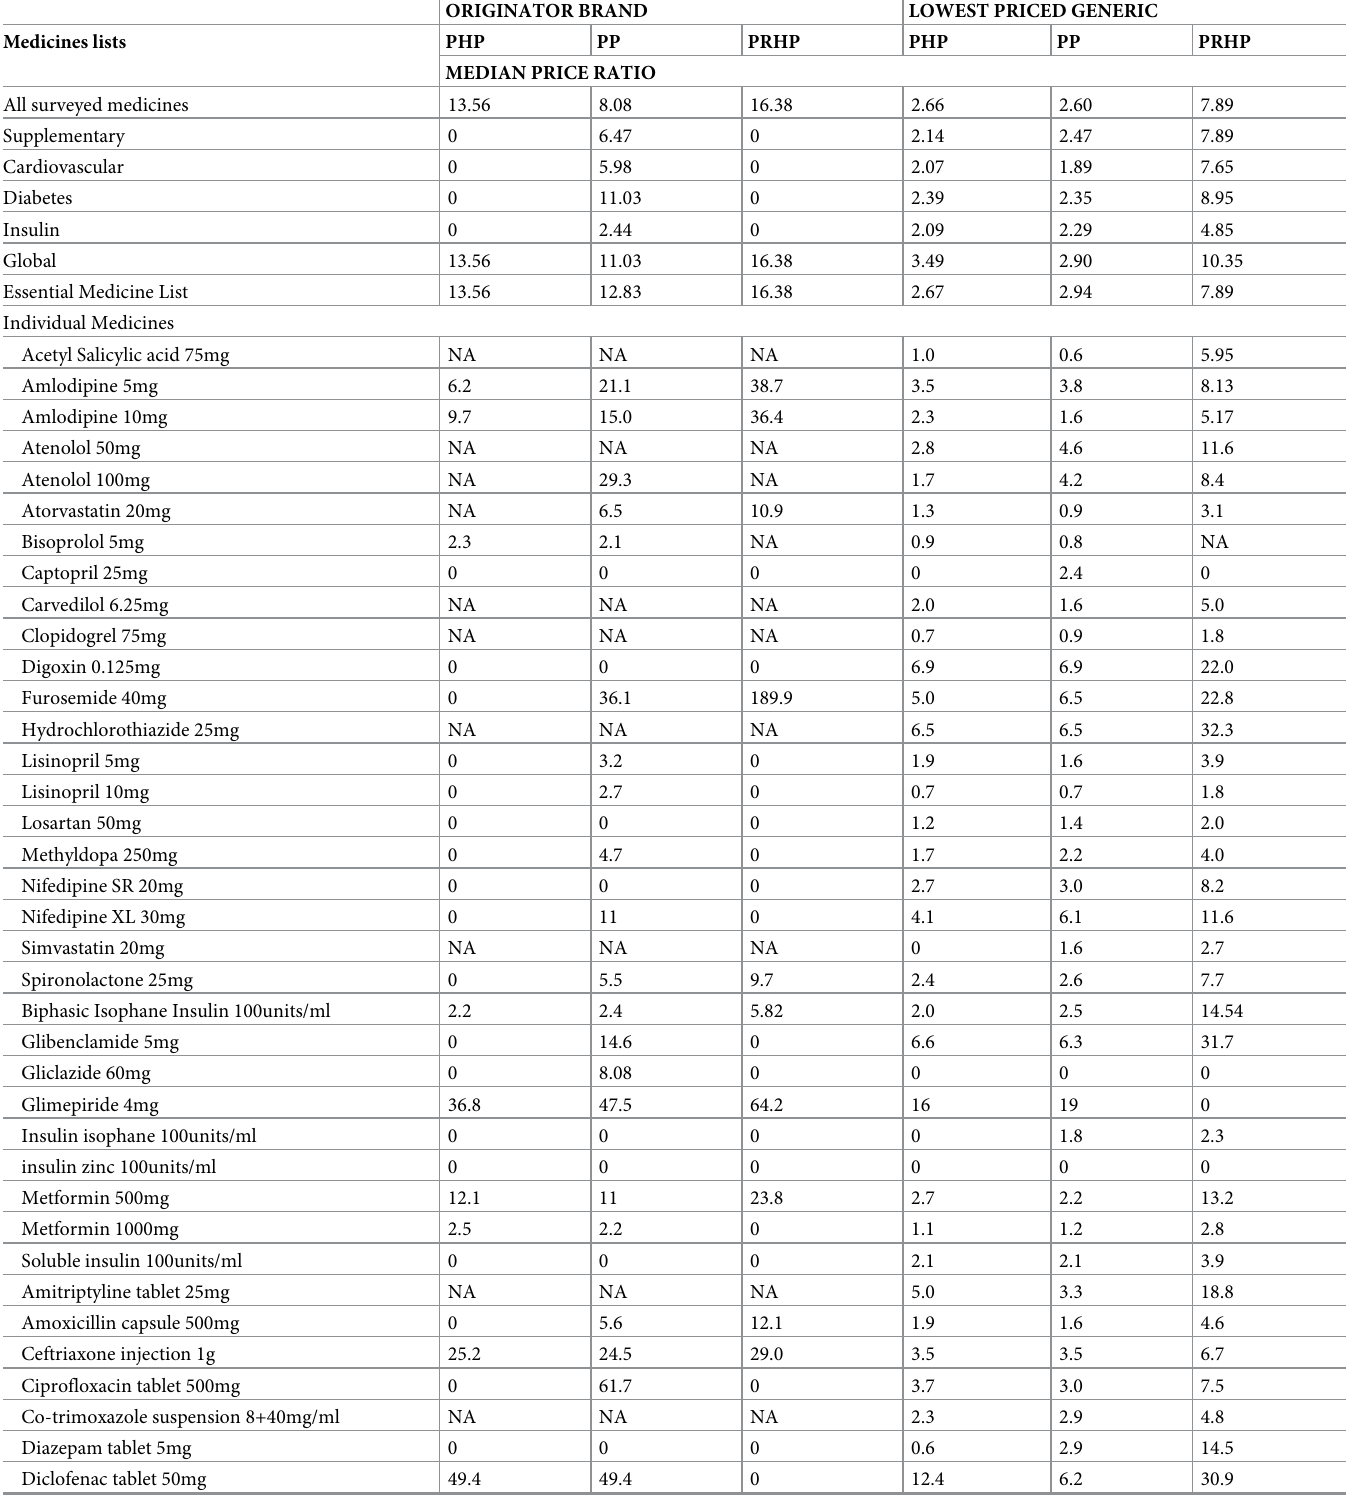
Table 3. Patient median price ratio (MPR) for medicine list and individual